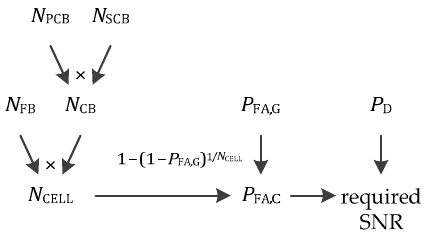
Figure 10. Parameters influencing the Signal-to-Noise Ratio (SNR) required.